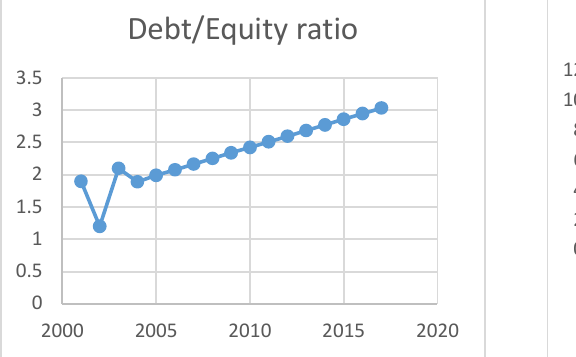
Fig. 3. Trend of Debt-Equity and Enterprise Value for Food Processing Firms in